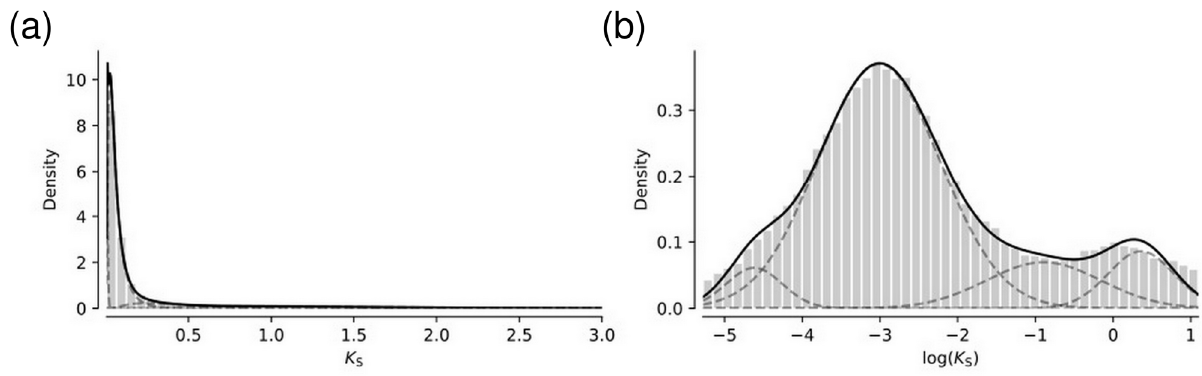
Figure 3. Distribution of synonymous substitutions per site ( K s) ( a ) and lg( K s) ( b ) inferring WGD events. Table 1. Comparison of gene number of A. argyi and other species.